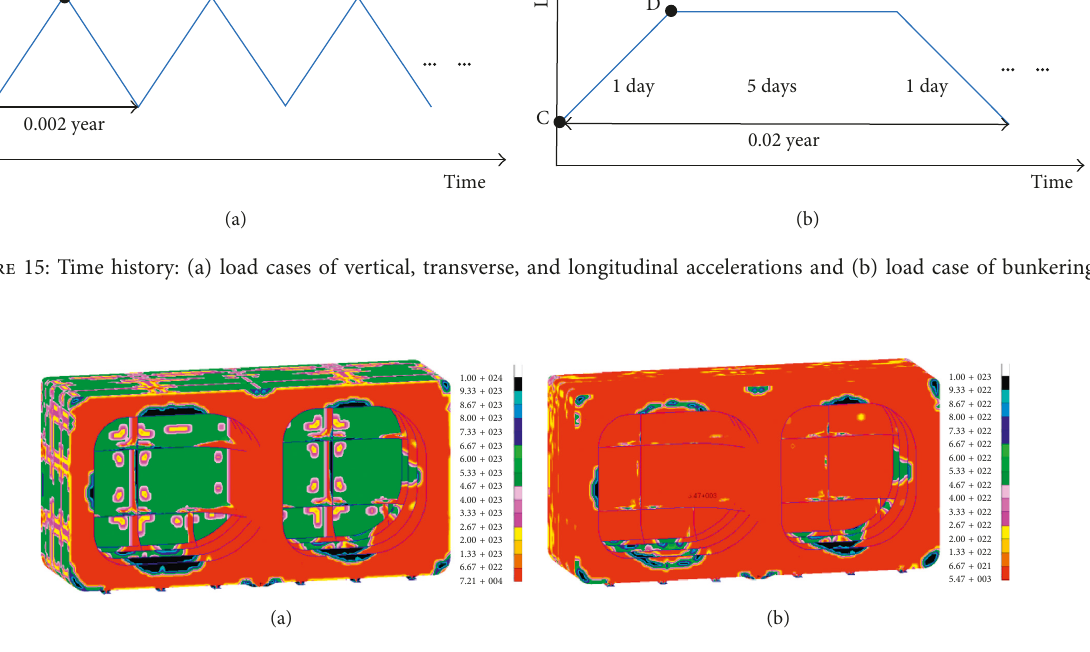
Figure 16: Fatigue analysis result: (a) load case of vertical acceleration and (b) load case of bunkering. Table 8: Fatigue analysis results according to each load case. Load cases